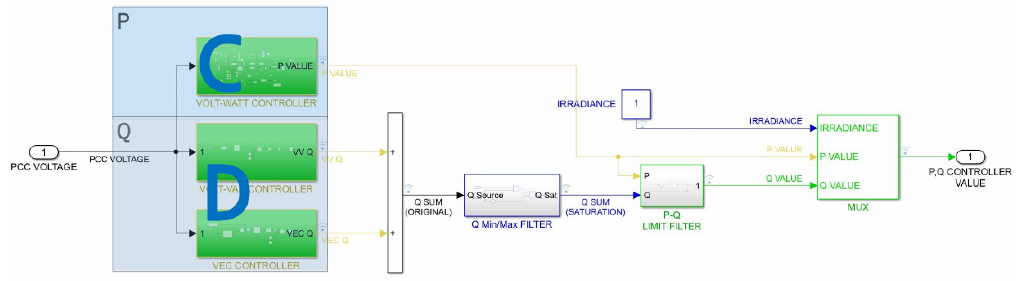
Figure 8. Illustration of the smart inverter active power and reactive power